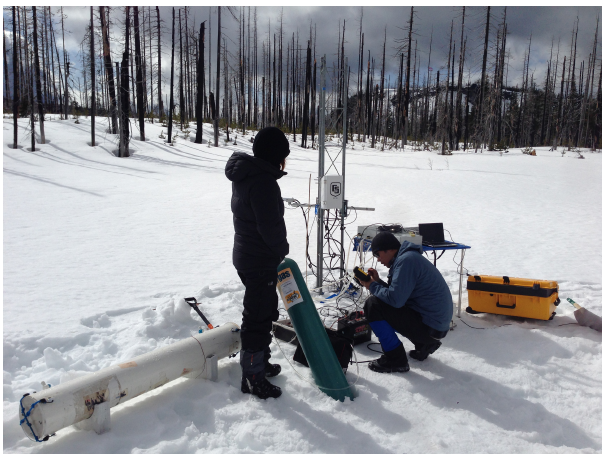
Figure 3. Picture of the calibration chamber (white PVC conduit) at the Santiam Pass site. Snow pickets are placed in low-profile col- lars to keep them separated within the chamber. Silicone is used to seal the chamber endplates, and duct seal is used to seal air gaps around the CO sensor wiring as it passes through the endplates. A dilute mixture of CO gas (green tank) is introduced into the cham- ber through an Aalborg GFM17 mass flowmeter and mixed by a fan within the chamber. CO concentration as measured by each sensor is acquired on a CR1000 logger (mounted in a weather-resistant case) for ∼ 10min at each concentration measured. After each concen- tration measurement, the CO gas mixture is evacuated to minimize sensor